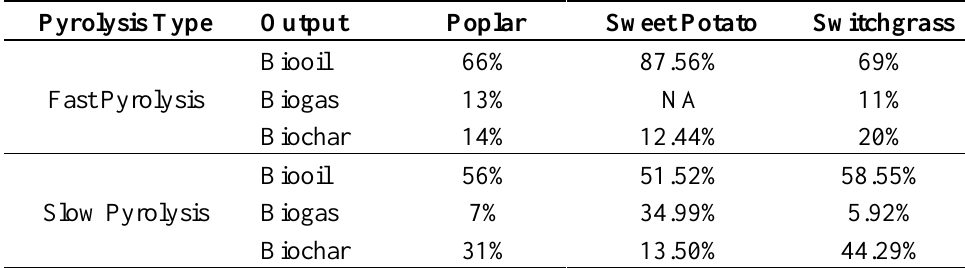
Table 2. Outputs from Fast and Slow